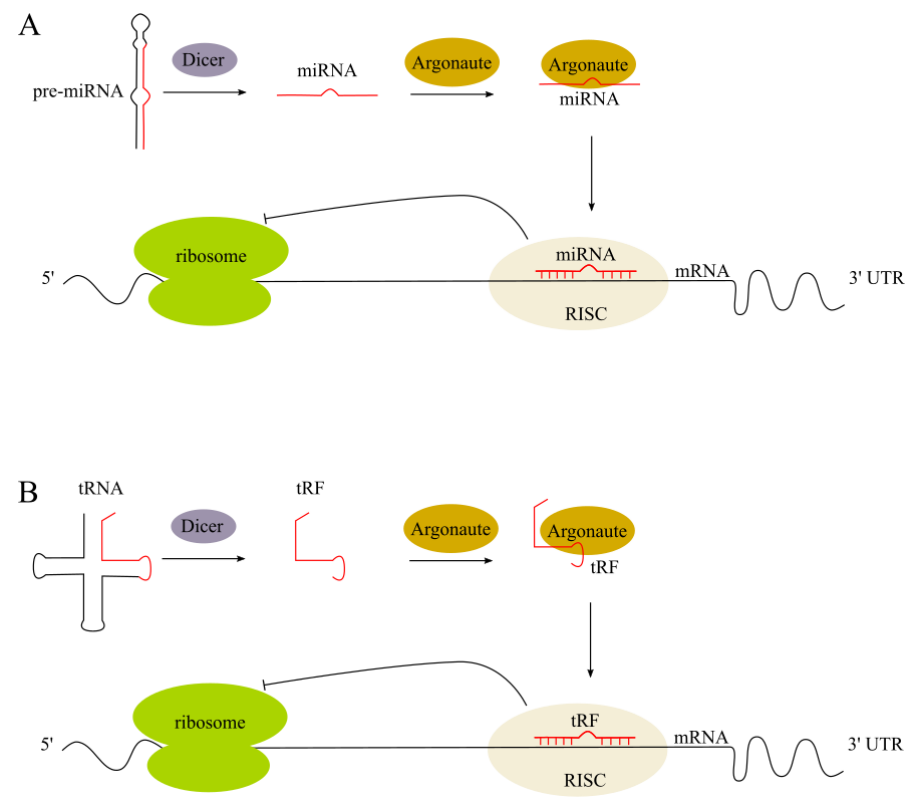
Figure 1. The classic endogenous miRNA pathway and miRNA ‐ like tRF function. ( A ) Pre ‐ miRNA is cleaved by the Dicer enzyme into the miRNA duplex. The guide strand is uploaded onto the RNA ‐ induced silencing complex (RISC) to regulate gene expression by causing either target mRNA degradation or translation repression; ( B ) mature tRNA is cleaved by the Dicer enzyme into the tRF, which is uploaded onto the RISC to regulate gene expression.